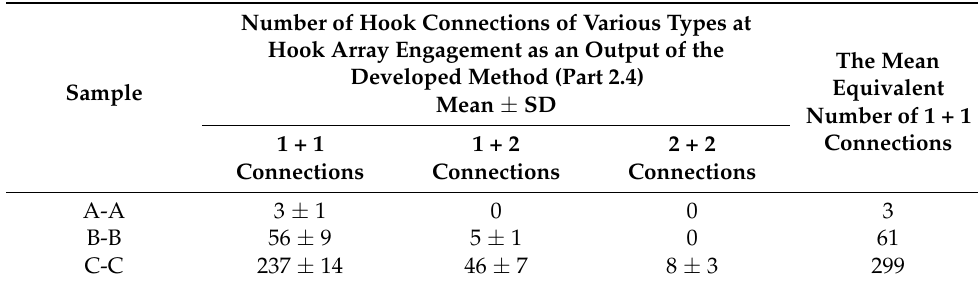
Table 5. Mean number of interlocked hooks for samples A-A, B-B and C-C and the mean equivalent number of 1 + 1 connections. SD means standard deviation. Number of Hook Connections of Various Types at Hook Array Engagement as an Output of Sample